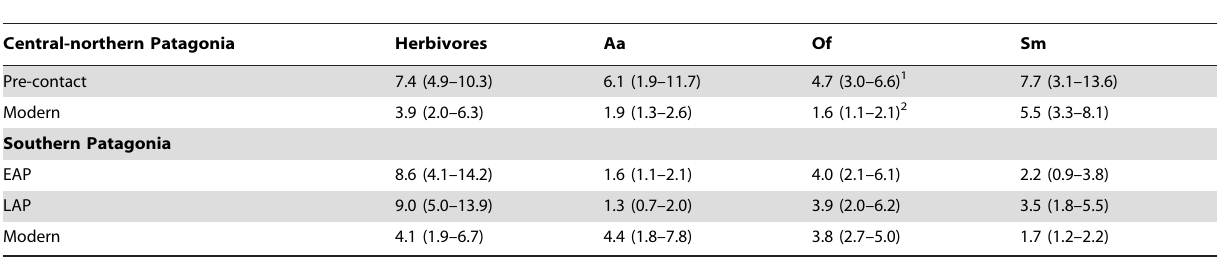
Table 7. Areas of the estimated Bayesian ellipses of the species/functional groups over the time in central-northern and southern